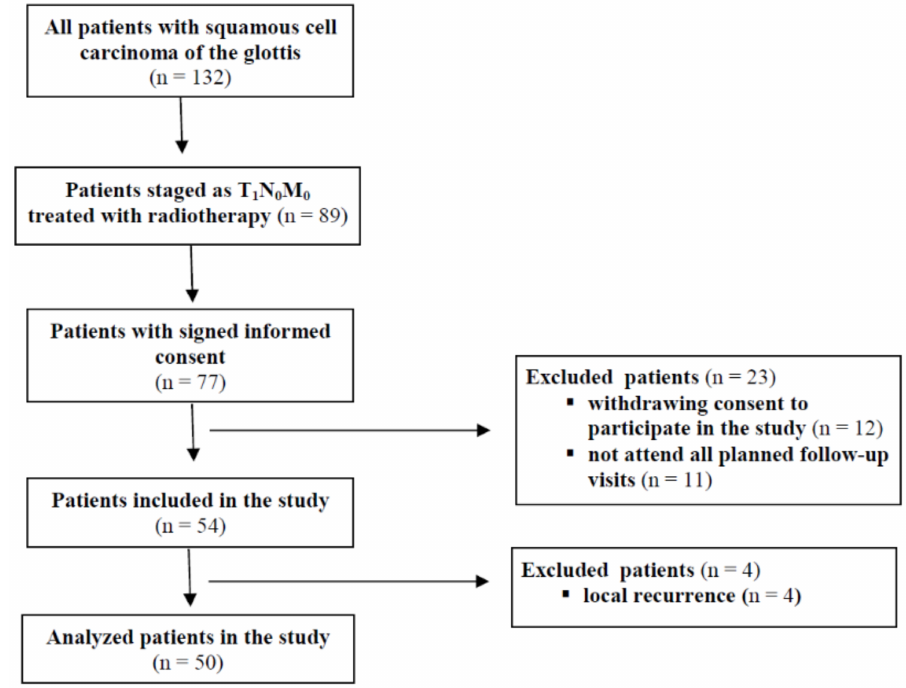
Figure 1. Study flowchart